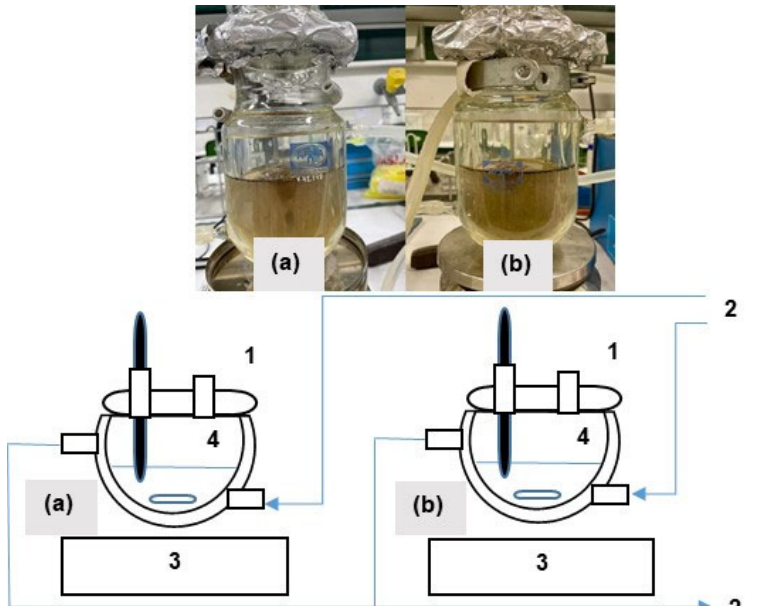
Figure 2. Experimental setup for crude oil degradation in liquid media. Reactor (1) temperature is controlled by a thermostat (2) and magnetically stirred (3). Liquid level in the reactor is half the value (4) of the total volume: 500 mL, and crude oil concentration is fixed in 1% v/v. ( a ) Bacillus licheniformis (CECT 20); ( b ) Pseudomonas putida (CECT 4614).